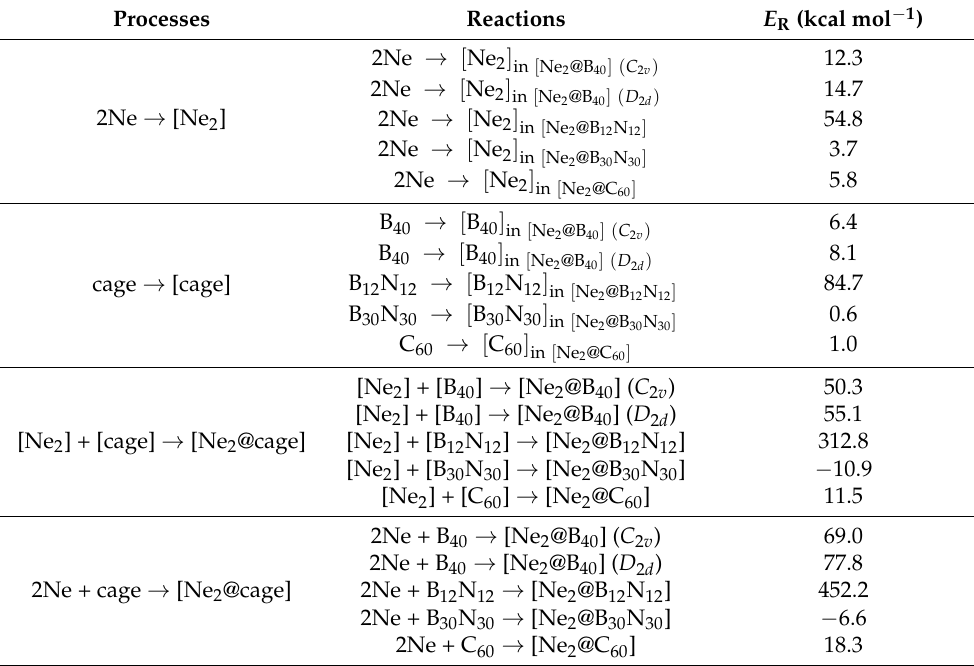
Table 2. Reaction energies calculated for all Ne 2 @cage